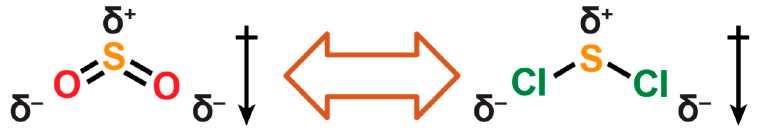
Figure 7. Schematic indication of the dipole in electropositive sulfur reagents.